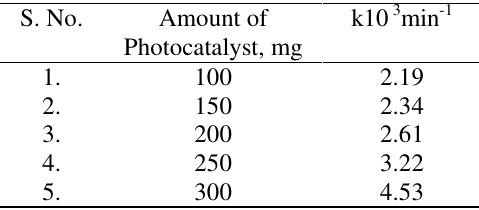
Table 4. Effect of amount of photocatalyst.